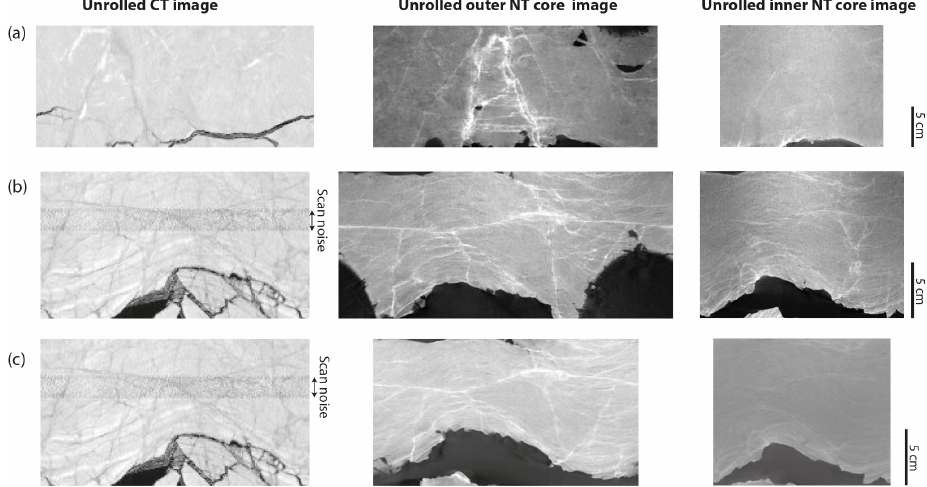
Figure 5. Comparison of unrolled images of core taken from CT and NT scans. Outer and inner core images are constructed from the NT scans to depict the difference in image quality between the outer core surface and the core interior. For core section intervals (borehole_core run and section_depth interval from the top of the core section in cm) (a) DFDP-1B_49-1_35-50 (depth interval 115.85–116.00m), (b)